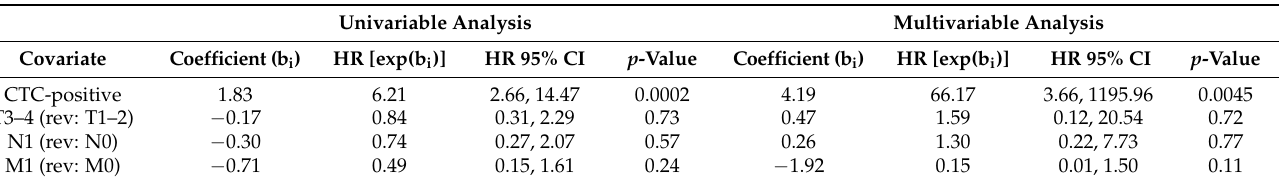
Figure 4. Kaplan–Meier curves. Overall survival of breast cancer patients based on CTC-status ( A ) and based on stable CTC-status or CTC conversion ( B ). Table 2. Cox proportional hazard ratios. Estimated coefficients of overall survival on breast cancer subjects. Calculated are the corresponding hazard ratio (HR), 95% confidence interval (CI) of the hazard ratio, and p -value in uni- and multivariable Cox proportional hazard analysis for CTC-status with negative as reverence, and T-, N-, and M-stage at initial